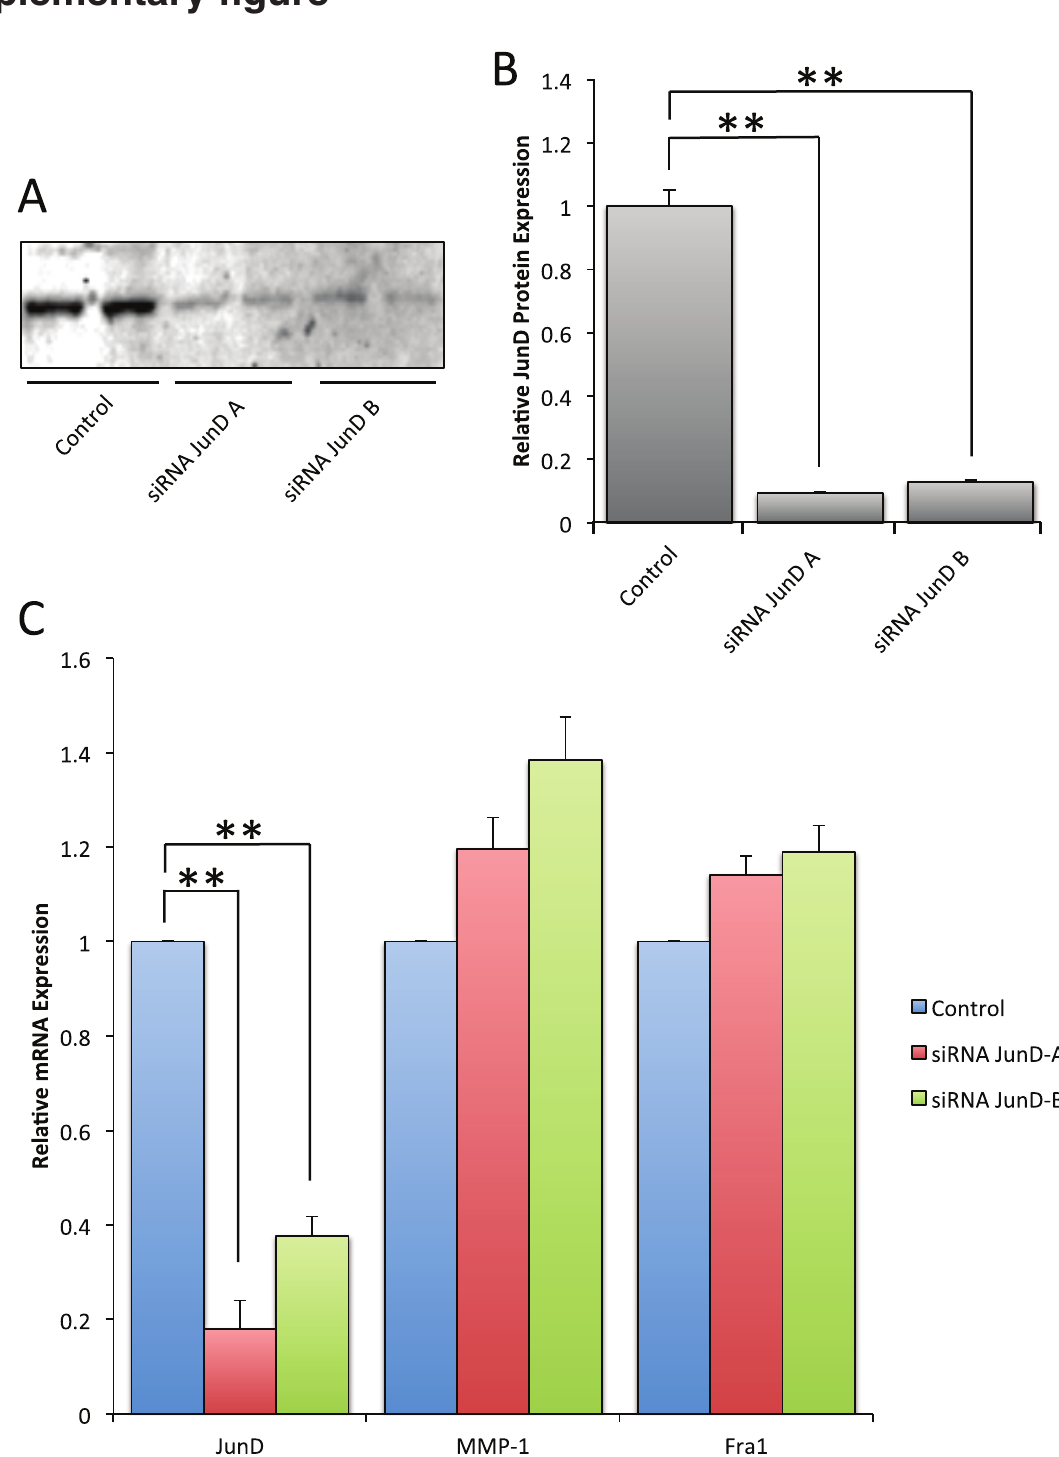
Supplemental Figure S1. JunD depletion with siRNAs has no effect on MMP-1 mRNA expression. A ) Immunoblot with anti-JunD antibodies of Scp-2 cells transfected with control or siRNA duplexes for JunD. B ) Mean JunD band intensity +/- standard deviation for immunoblots from three independent experiments as in ( A ). C ) qPCR of JunD, MMP-1 and Fra-1 in Scp-2 cells transfected with control or siRNA duplexes for JunD. Mean relative values are +/- standard deviation from three independent experiments are shown. **, p < 0.005 for two-tailed